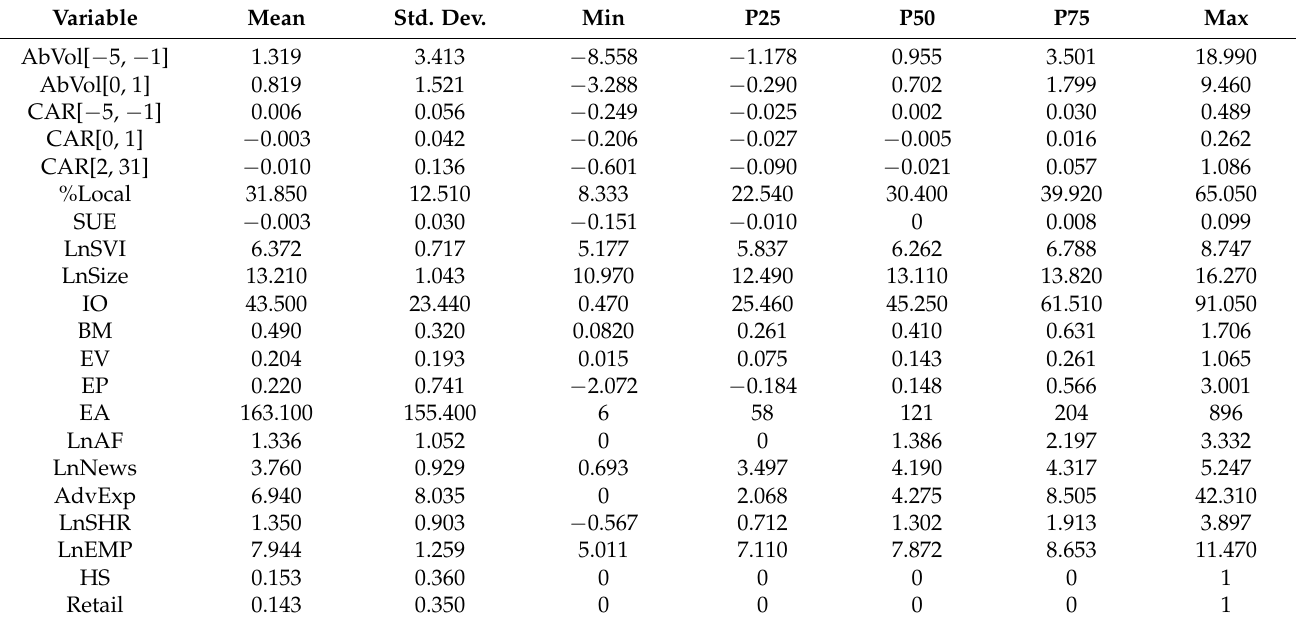
Table 1. Descriptive Statistics for the Base Sample of 7214 Observations.